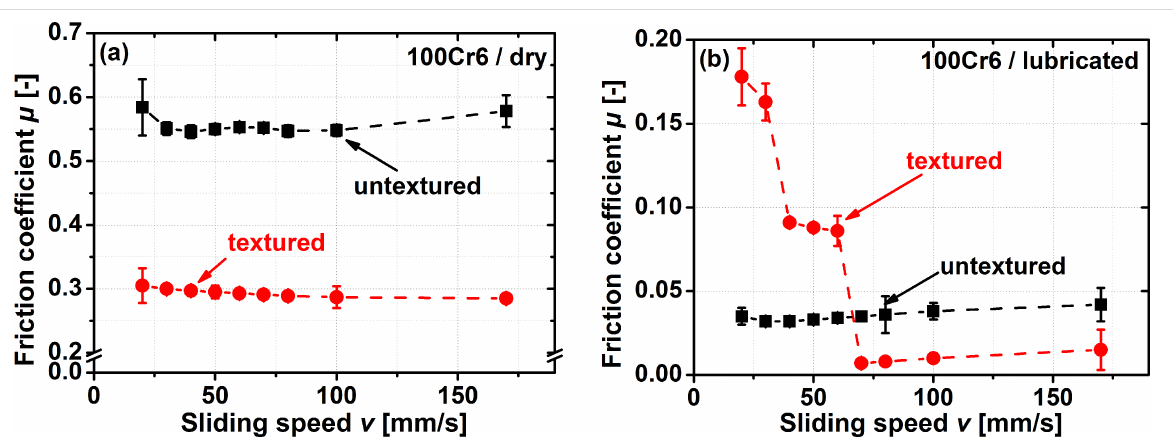
Figure 2: Stribeck curve-like pin-on-disc experiments for a variation in sliding speed from 20 to 170 mm/s for dry (a) and lubricated (b) steel-on-steel contacts. The normal force was 2 N during all experiments.